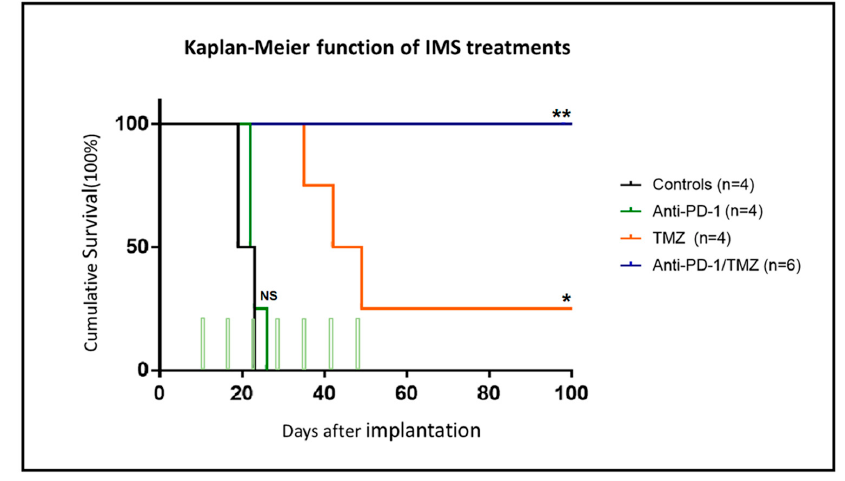
Figure 2. Survival Kaplan–Meier curves of mice in different therapy groups. Mice treated with control isotype murine IgG 100 μ g/day ( n = 4, black line), anti-PD-1 100 μ g/day ( n = 4, green line), anti-PD-1 100 μ g/day combined with TMZ 60 mg/kg ( n = 5, blue line) and TMZ 60 mg/kg alone ( n = 4, orange lines), the green columns indicating therapy administration time points. Note: mouse C1403 (combination therapy group) died on day 98 p.i. during the re-challenge experiment (not recovering from anaesthesia). MRI scanning did not show a relapsing tumour; accordingly, GB did not cause its death, and this individual was excluded from the survival curve calculations since it died from unknown reasons. ** p < 0.01, * p < 0.05 and NS = no significant difference for the Log-Rank test for the comparison between treated groups and control group.